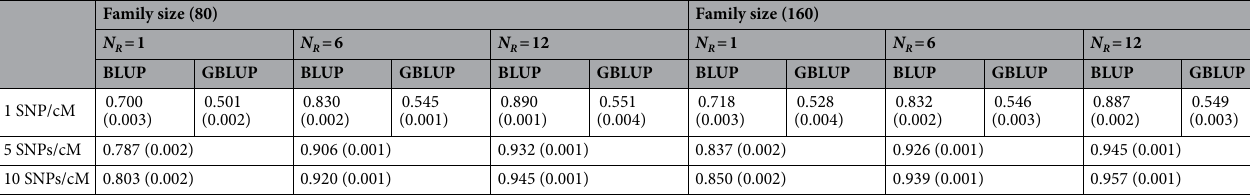
Table 1. Accuracy of breeding values as a function of family size, clonal size N R , and marker density (SNPs/ cM). N R = 1 means no-cloning (1 ramet per